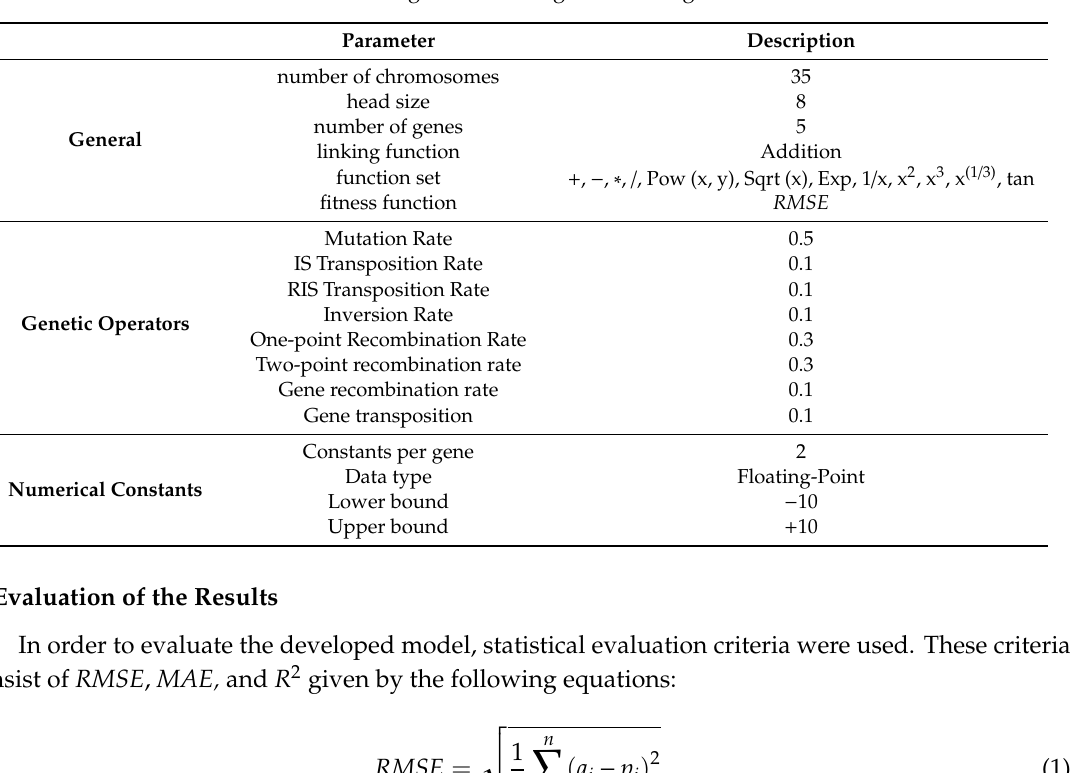
Table 4. Configuration settings for GEP